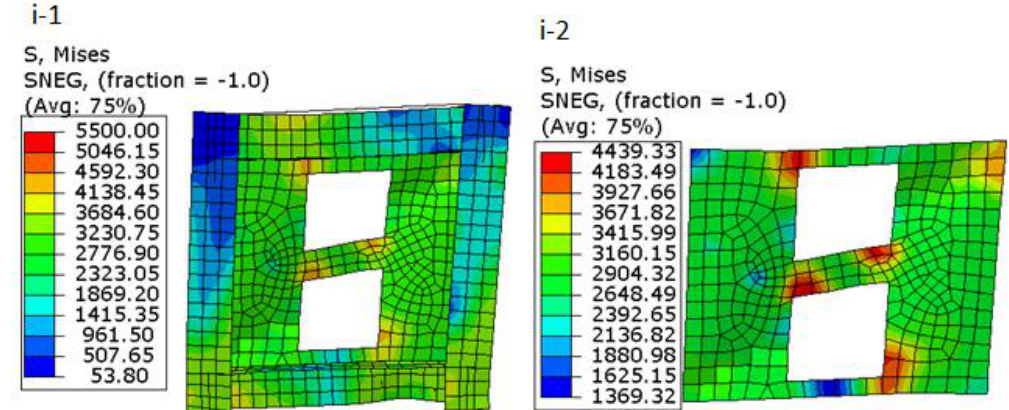
Figure 25. Von Mises stress and displacement for concrete part (h-3) stress and (h-4) displacement.